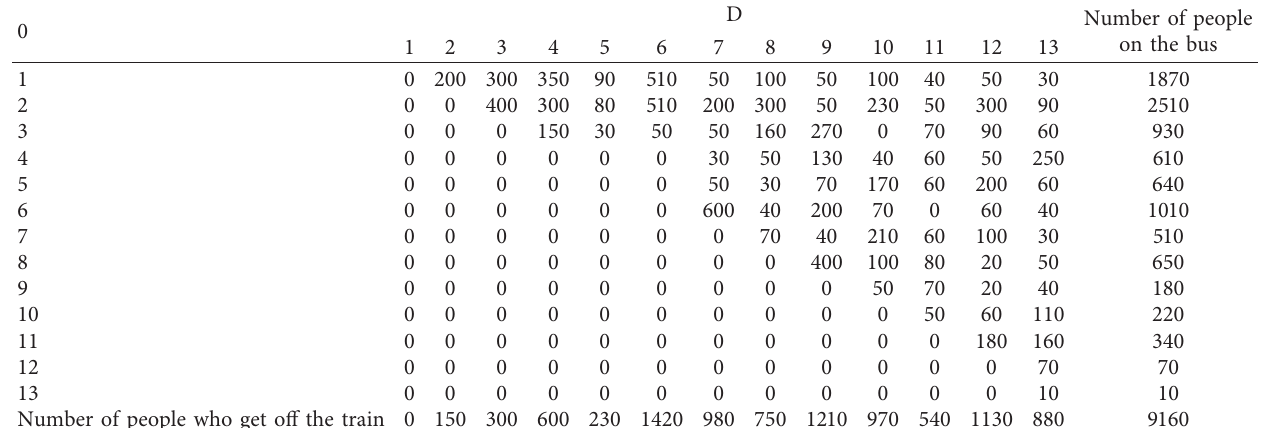
Table 1: 0-D passenger flow (unit: persons/unit time).